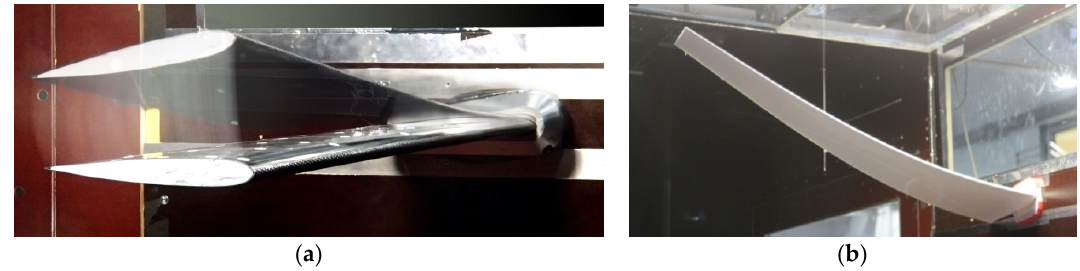
Figure 1. Wind tunnel models in previous test campaigns, maximum tip delection objective. ( a ) Rect. wing. ( b ) Forward swept wing.